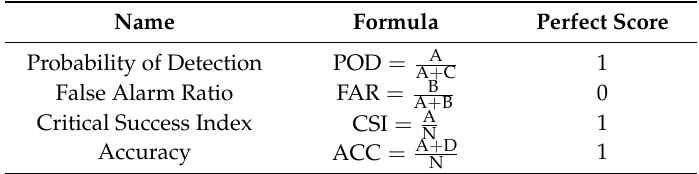
Table 4. Formulas of categorical metrics, where A: number of hits, B: number of false alarms, C: number of misses, and D: number of correct negatives. N: number of events.